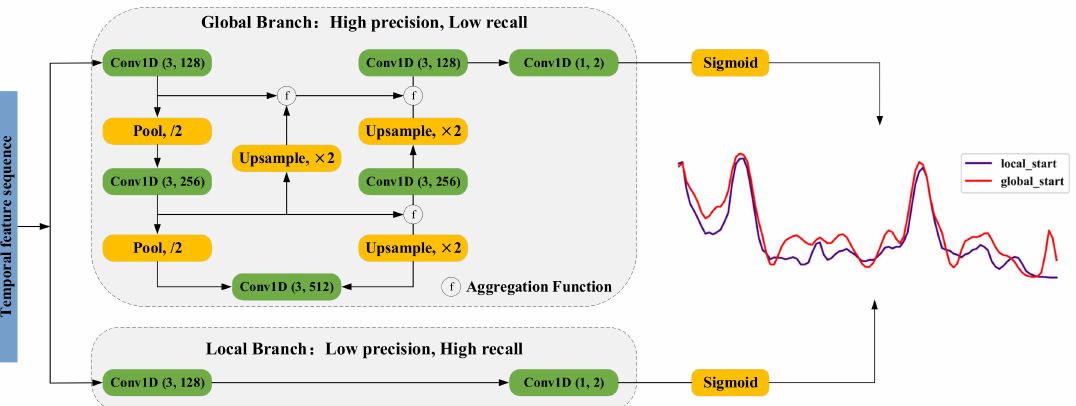
Figure 5. The architecture of Temporal Boundary Generator (TBG). TBG contains local and global branches to generate high-recall and high-precision boundaries. Pool stands for the down-sample operation and ○ f stands for aggregation operation and